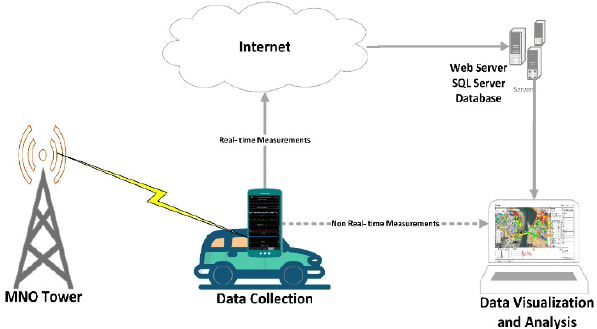
Figure 3. A typical methodology for MBB drive test [40].